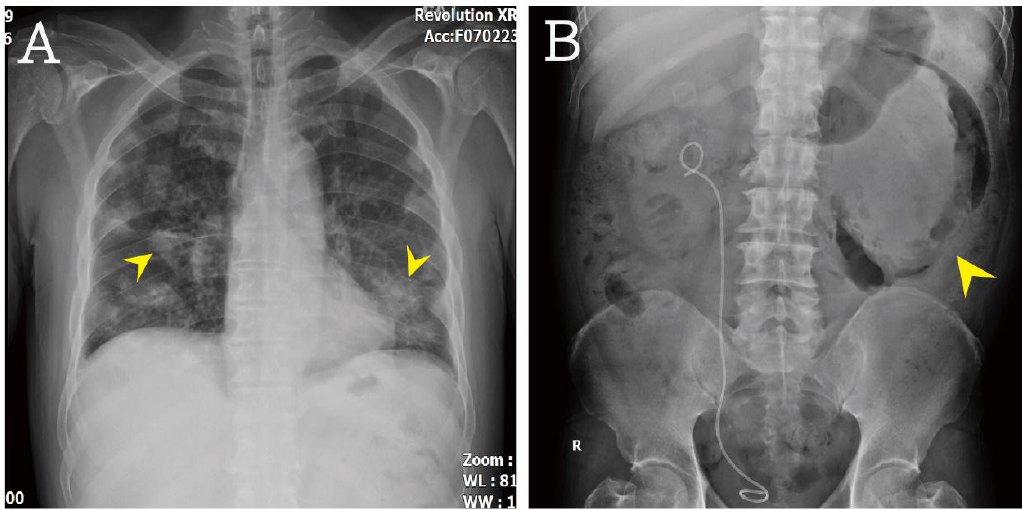
Figure 1. ( A ): Multiple opacities over bilateral lung field were noted (arrow head). ( B ): A heterogeneous mass with air density at left side (arrow head) was found.